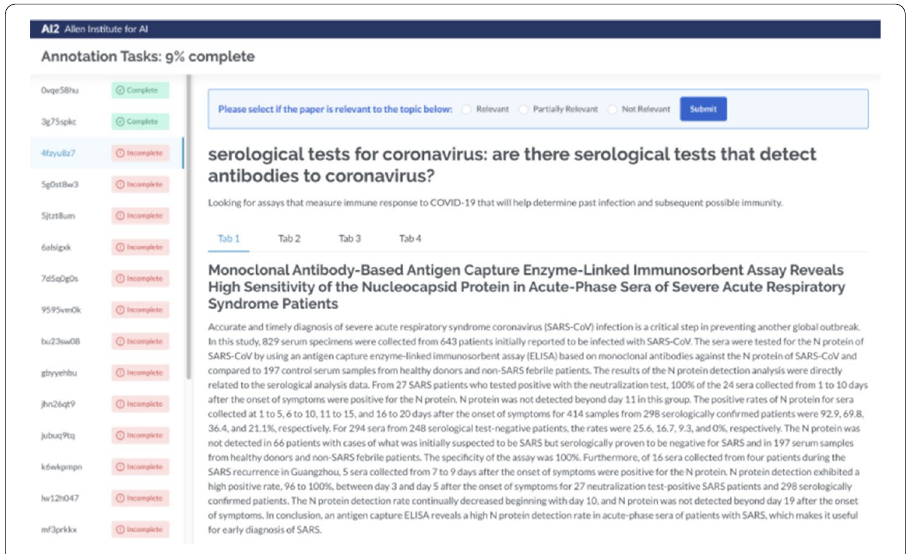
Fig. 3 Interface for human labeling TREC-COVID documents (Image taken from Voorhees et al.